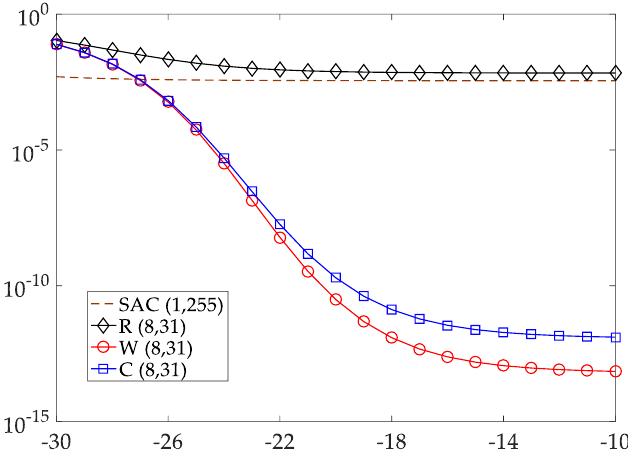
Electronics 2018 , 7 , x FOR PEER REVIEW Figure 7. LER versus P for the three label stacking scenarios. Figure 7. LER versus P for the three label stacking scenarios.